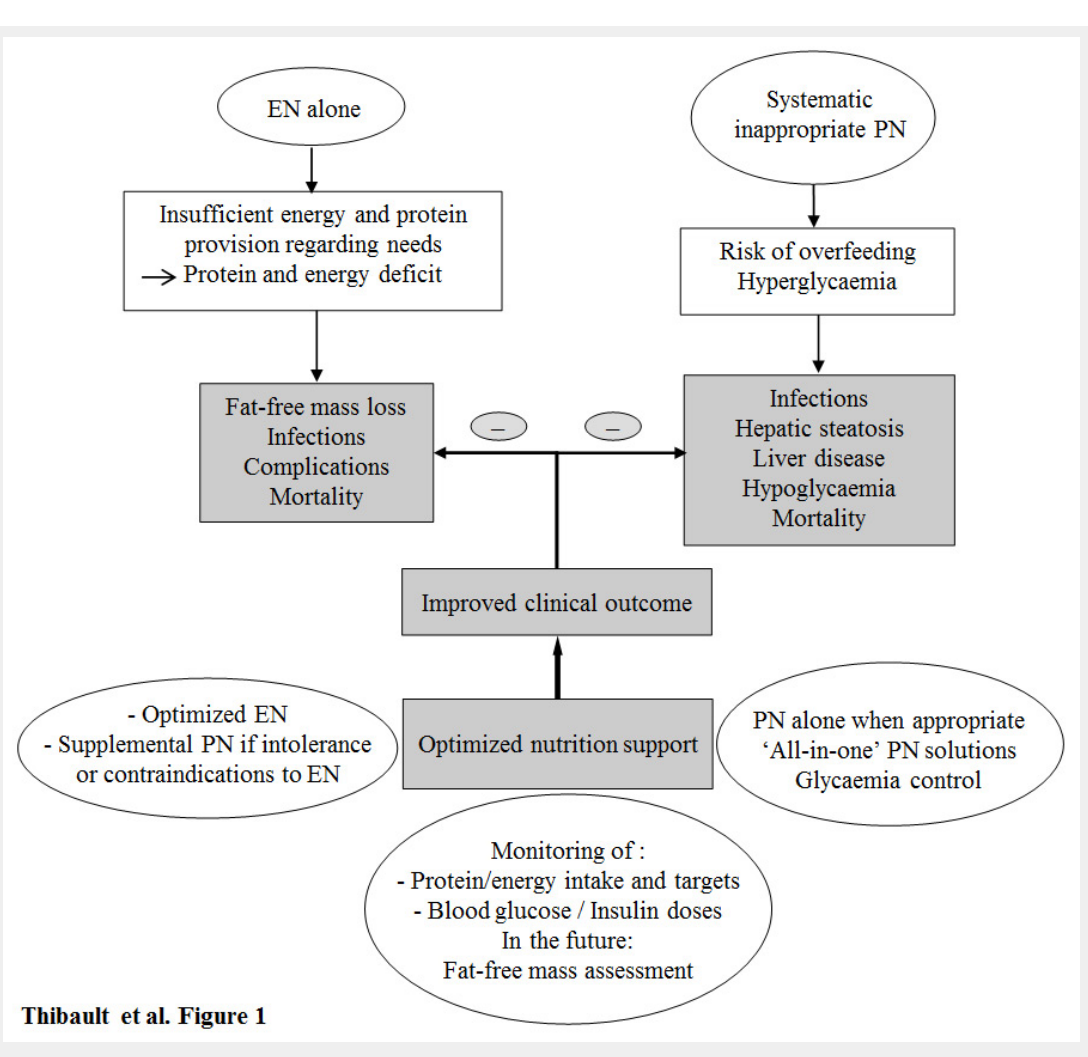
Figure 1 Improved clinical outcome with optimised nutrition support and monitoring in the intensive care unit. Enteral nutrition (EN) alone is often associated with an insufficient energy provision, leading to energy deficit; the latter is associated with fat-free mass loss, increased risk of infections and complications, and increased mortality. Systematic parenteral nutrition (PN) without appropriate indication is associated with increased risks of overfeeding, hyperglycaemia, and promotes infections, hepatic steatosis, liver disease, hypoglycaemia (as a result of high insulin doses), and mortality. Optimal nutrition support improves the clinical outcome. It includes the adequate choice of nutritional support: i) EN in first line, then together with supplemental parenteral nutrition in case of failure or contraindication to optimised EN; ii) parenteral nutrition alone when appropriate with respect to the indications, the preferred use of ‘all-in-one’ solutions, and the glycaemic control; iii) the nutritional and metabolic monitoring: adequation of protein/energy provision towards target, blood glucose and insulin doses according to on-going protocols. The assessment of fat-free mass may become the key part of the nutritional management of ICU patients, but validation studies are